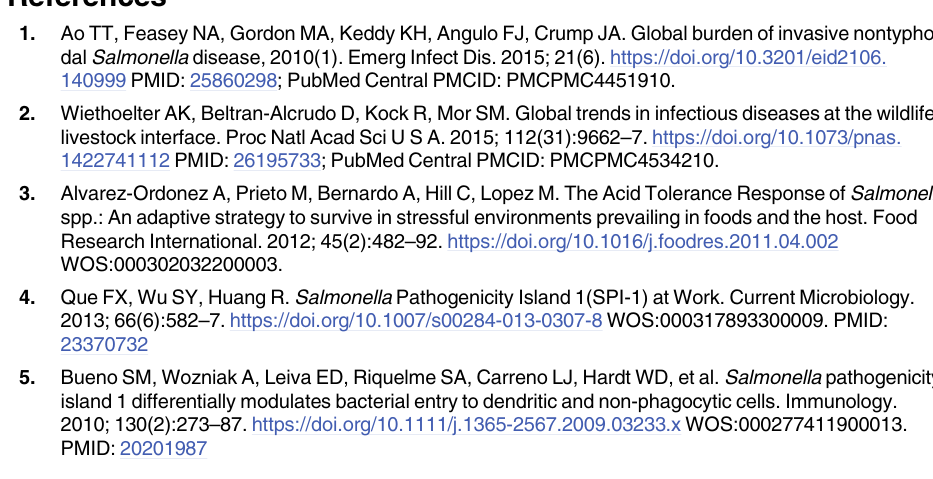
S5 Fig. ATP pools in Δ atpB Salmonella . (A) ATP pools in WT, Δ atpB , and Δ ackA Δ pta Sal- monella was estimated with firefly luciferase and normalized to culture density (N = 6, mean ± S.E.M.). Selected cultures were treated with 750 μ M spermine NONOate (sNO). (B) Effect of 750 μ M spermine NONOate (sNO) on the growth of Salmonella . The Δ pykAF Δ ackA Δ pta mutant was complemented with the low copy number plasmid pWSK29 harboring the ackA pta operon (pACKPTA). (C) Intracellular growth of the indicated Salmonella strains after 16h of culture in J774 cells. (D) Production of nitrite by Salmonella -infected, periodate- elicited macrophages was estimated spectrophotometrically by the Griess